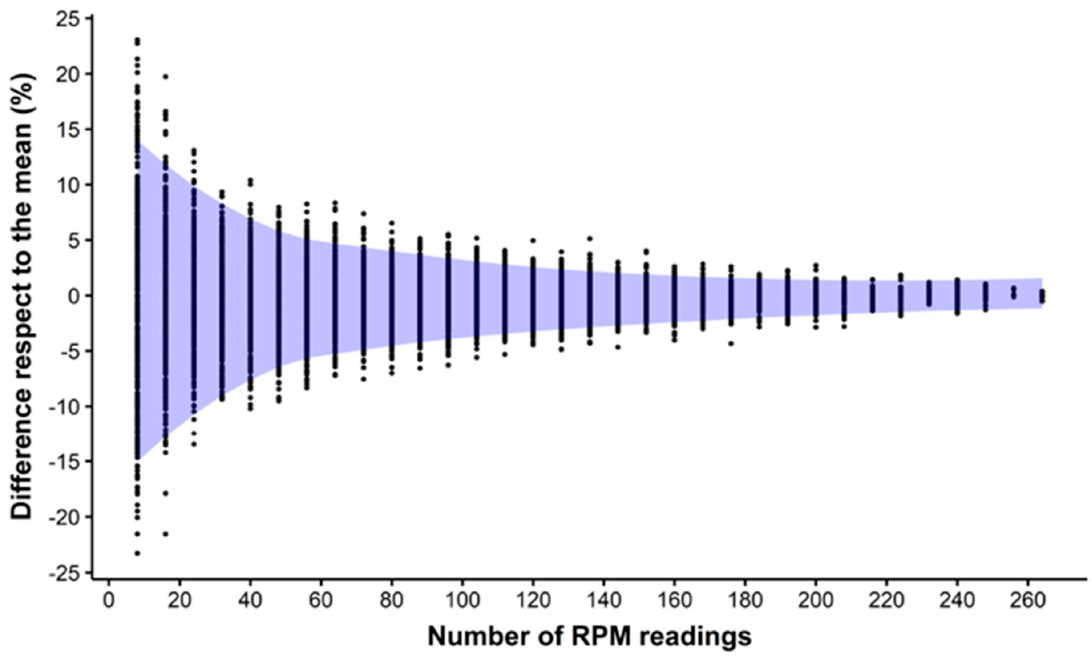
Figure 4. Effect of the number of readings on the accuracy of the rising plate meter. Zero represents the pasture biomass of the paddock when all the readings of a specific date were averaged. The purple area shows the confidence interval (CI, 95%). Confidence interval’s upper and lower limits values were smoothed using locally weighted scatterplot smoothing (LOESS).